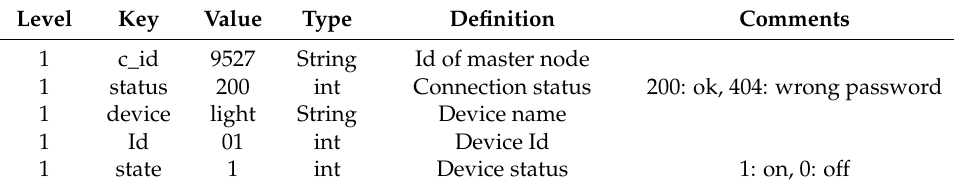
Table 5. General response packet structure and codes of status.